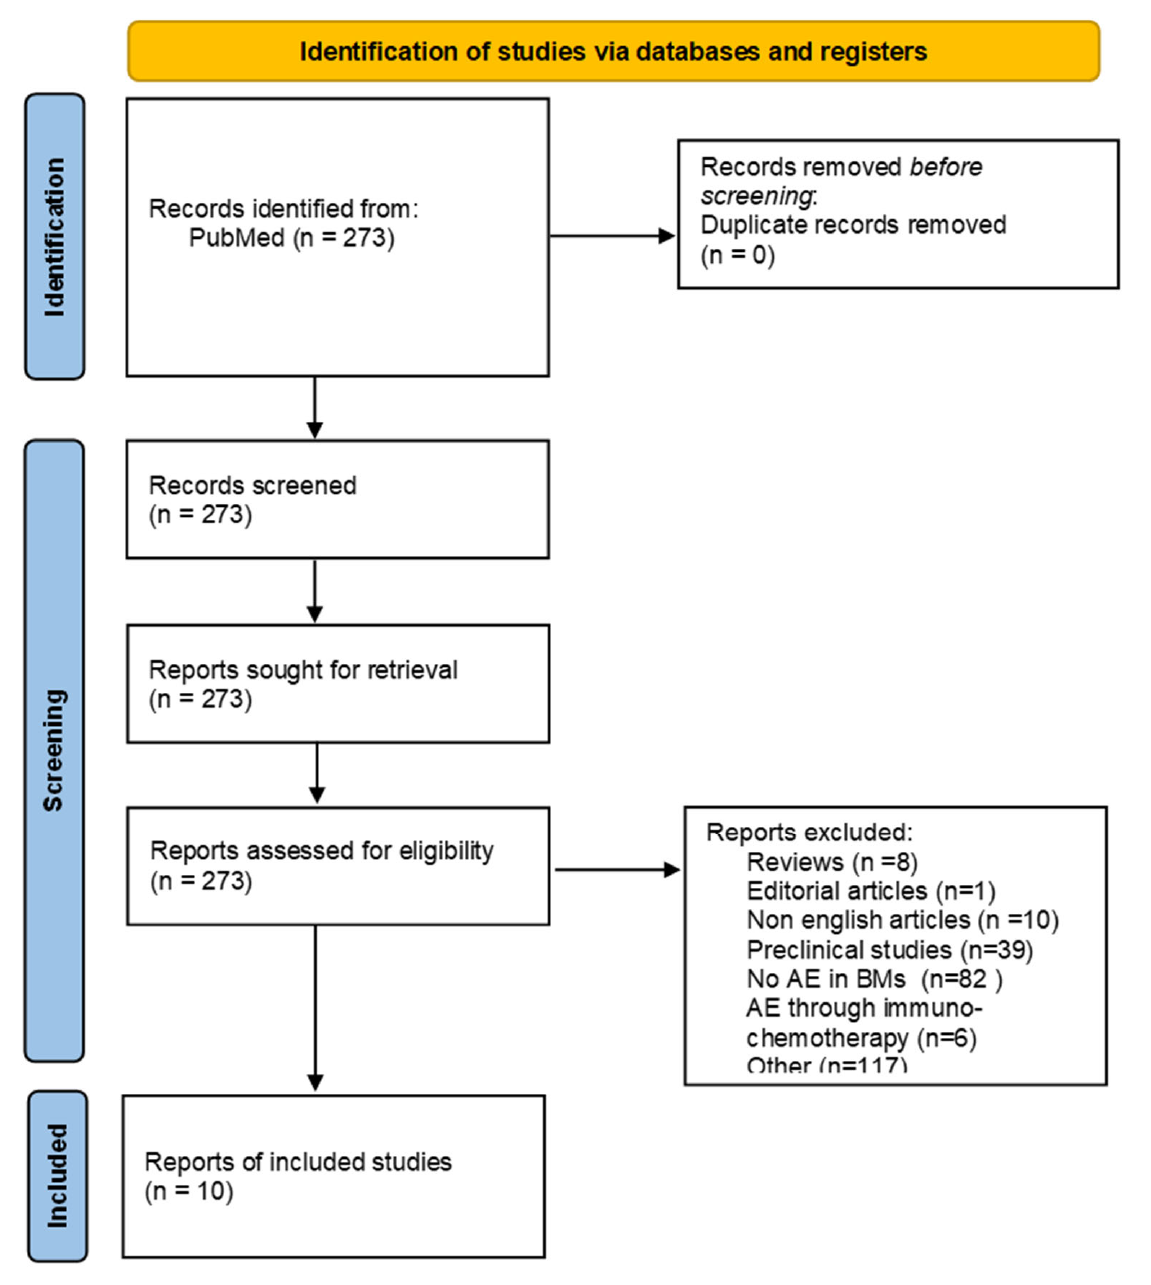
Figure 1. Representation of the PRISMA work fl ow for the selection of articles.